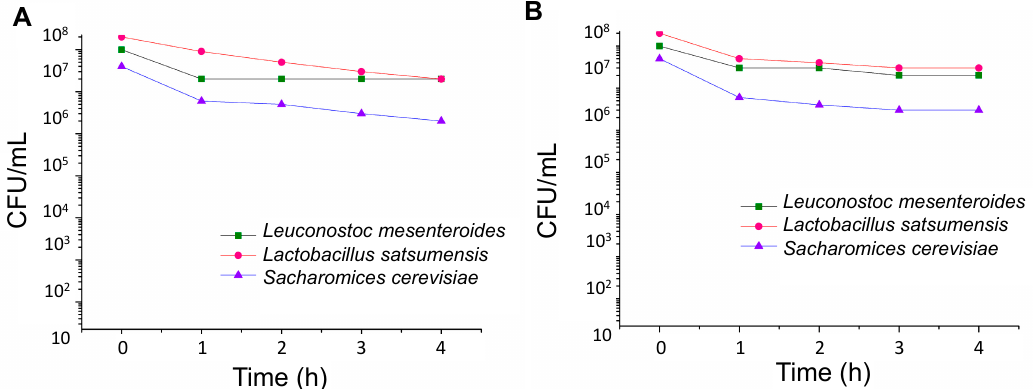
Figure 2. Resistance to simulated gastric juice containing pepsin ( A ) and intestinal juice containing pancreatin ( B ) of Lactobacillus satsumensis LPBF1, Leuconostoc mesenteroides LPBF2, and Saccharomyes cerevisiae LPBF3 kefir strains.